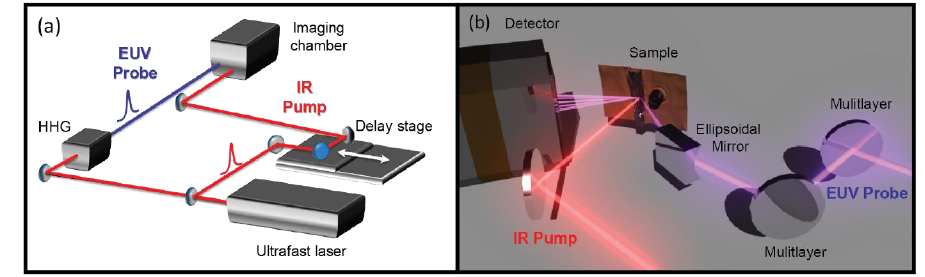
Fig. 1. The experimental setup. (a) The beam geometry of the two experimental arms. (b) A view inside the imaging chamber, showing the CDI microscope configured in a pump probe